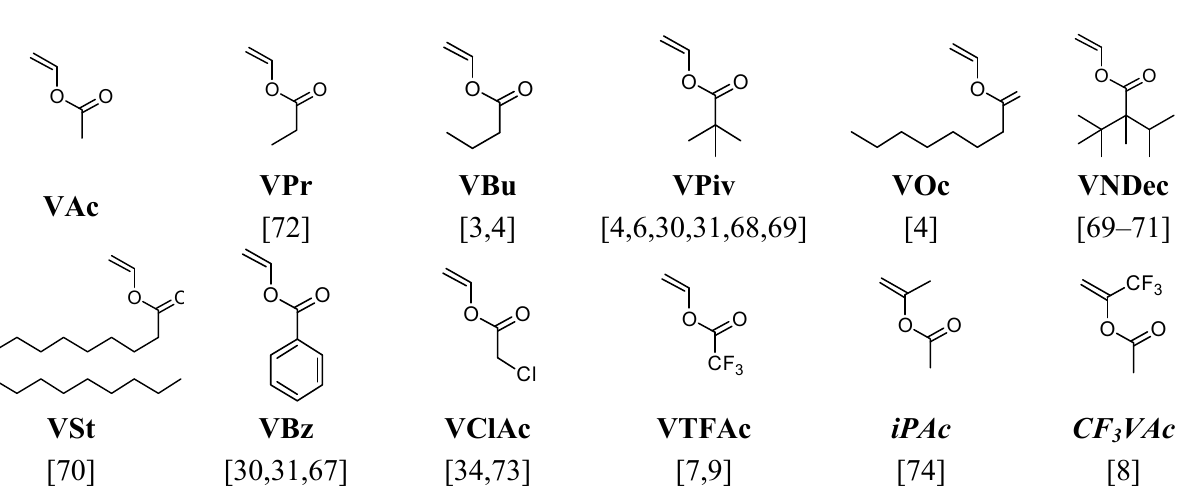
Scheme 3. Vinyl esters in RAFT (co)polymerization. RAFT homopolymerization of monomers in italics has not been